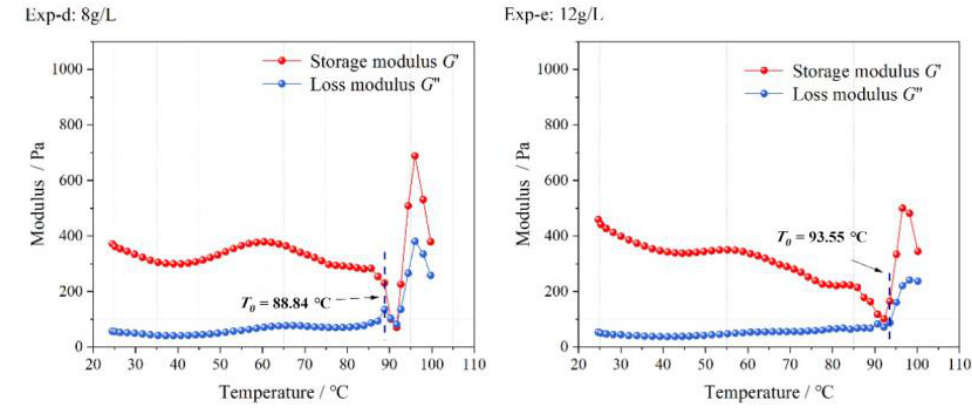
Figure 10. Colloid elastic modulus with increasing temperature at different contents of LMP.